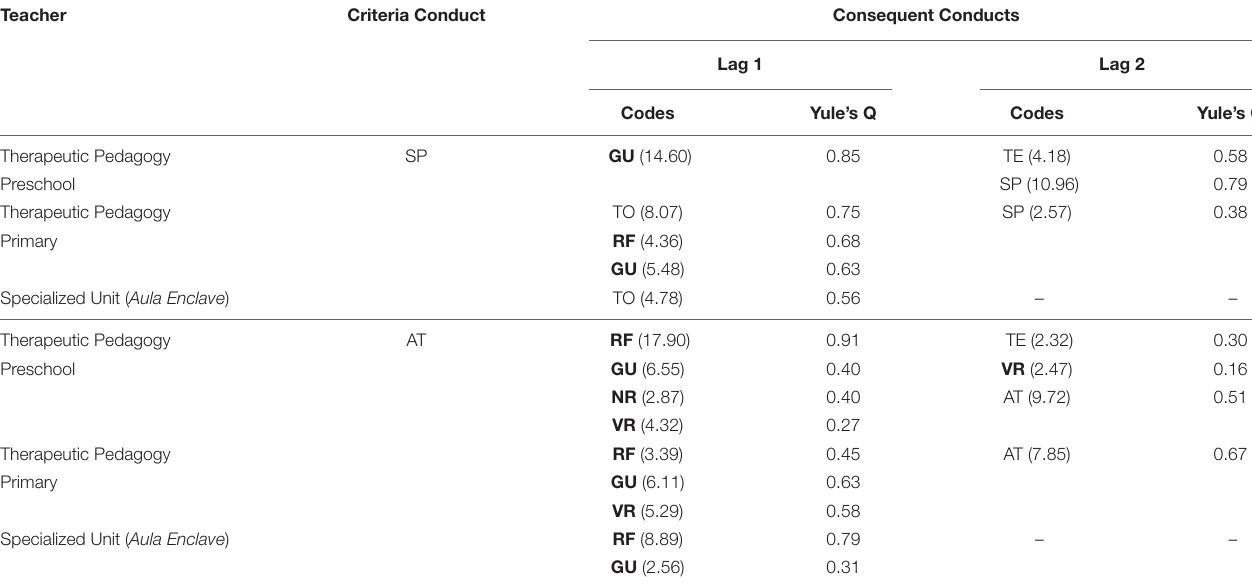
TABLE 11 | Positive Interventions of Students.